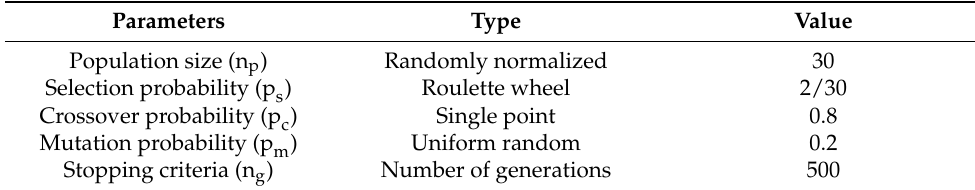
Table 4. Parameters of the MOGA